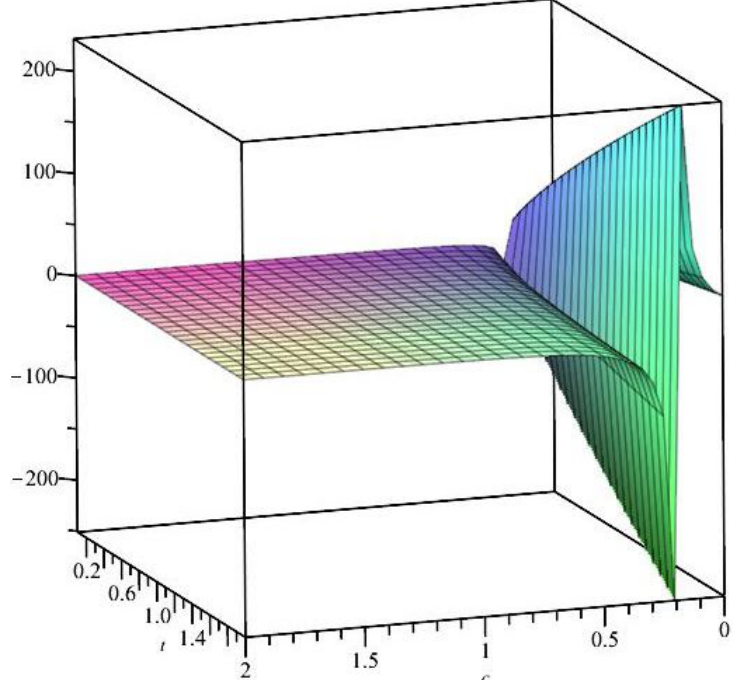
Figure 1. The variation of S { c } w.r.t. c ∈ ( 0, c 0 ) (cid:83) ( c 0 ,2 ) and θ 2 : = t .